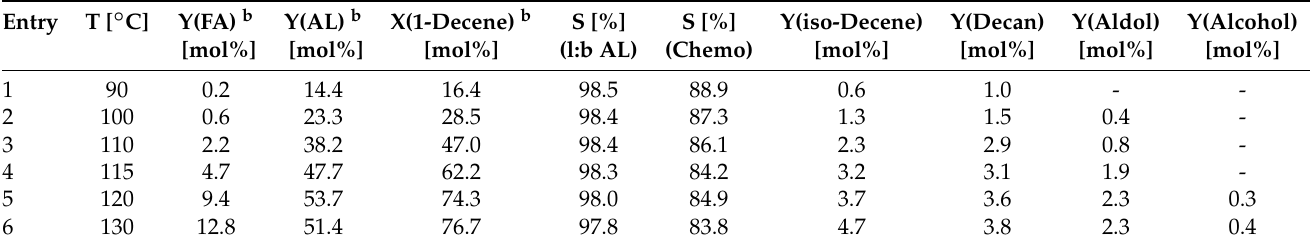
Table 2. Effect of temperature on the reaction performance and selectivity of hydroaminomethylation of 1-decene with diethylamine a